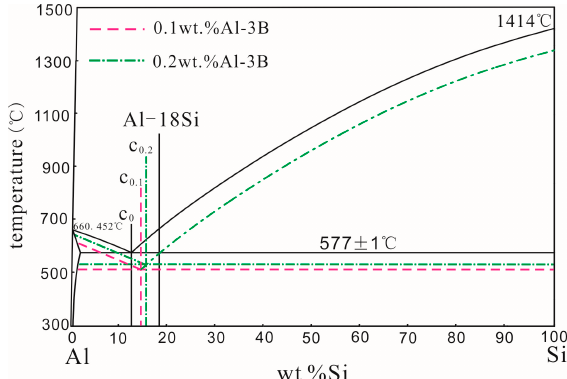
Figure 3. Schematic of eutectic point variation of an Al–Si alloy modified with a smaller amount of Al–3B.